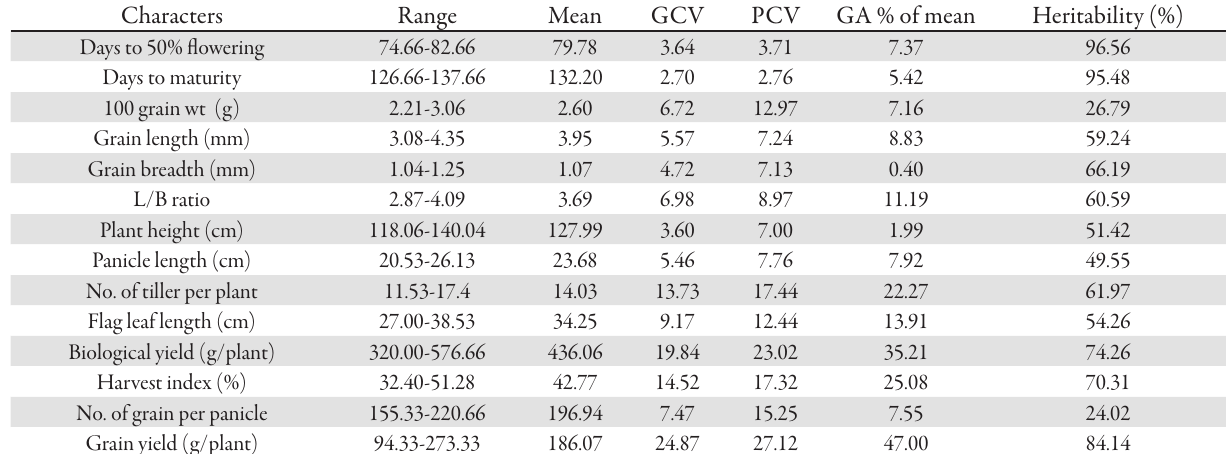
population of hill rice 3